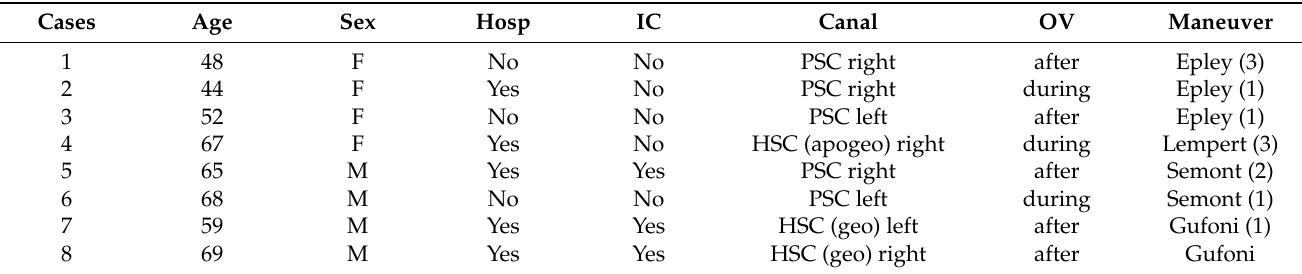
Table 1. (Patients’ data) (Legend: Hosp = hospitalization; IC = intensive care; OV: onset vertigo; maneuver; type and number of